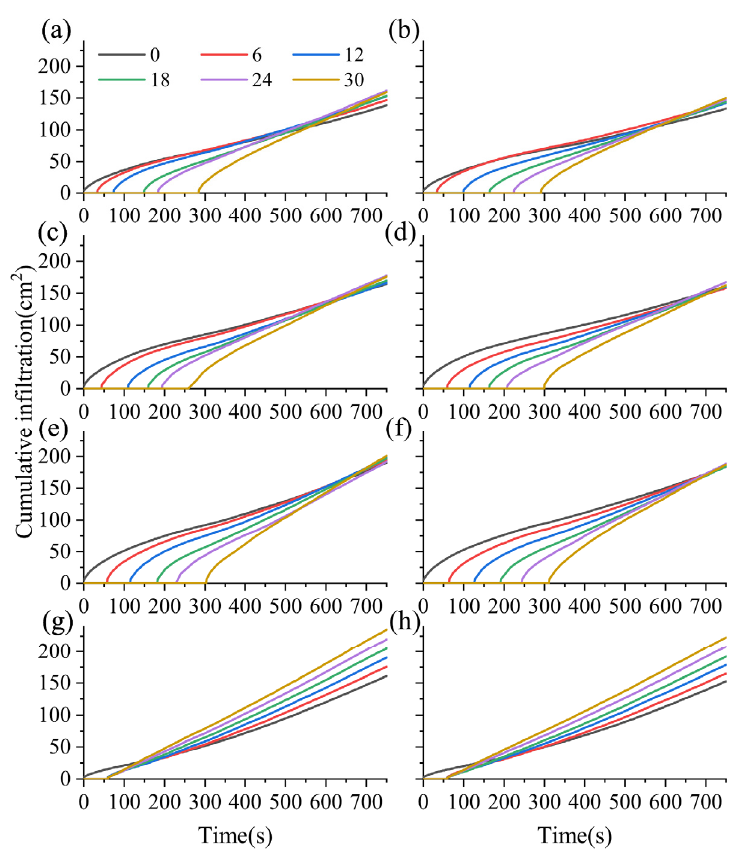
Figure 7. Cumulative infiltration curve for all treatments. ( a ) B1; ( b ) A1; ( c ) B2; ( d ) A2; ( e ) B3; ( f ) A3; ( g ) B4; ( h ) A4. ( g ) B4; ( h )